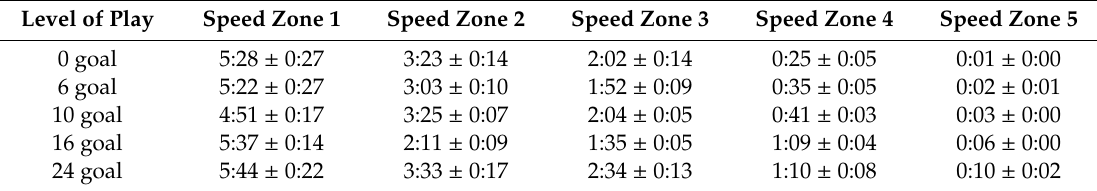
Table 2. Time (minutes: seconds) spent in each speed zone, per chukka at each level of play. Data are presented as means ± 90% confidence intervals.